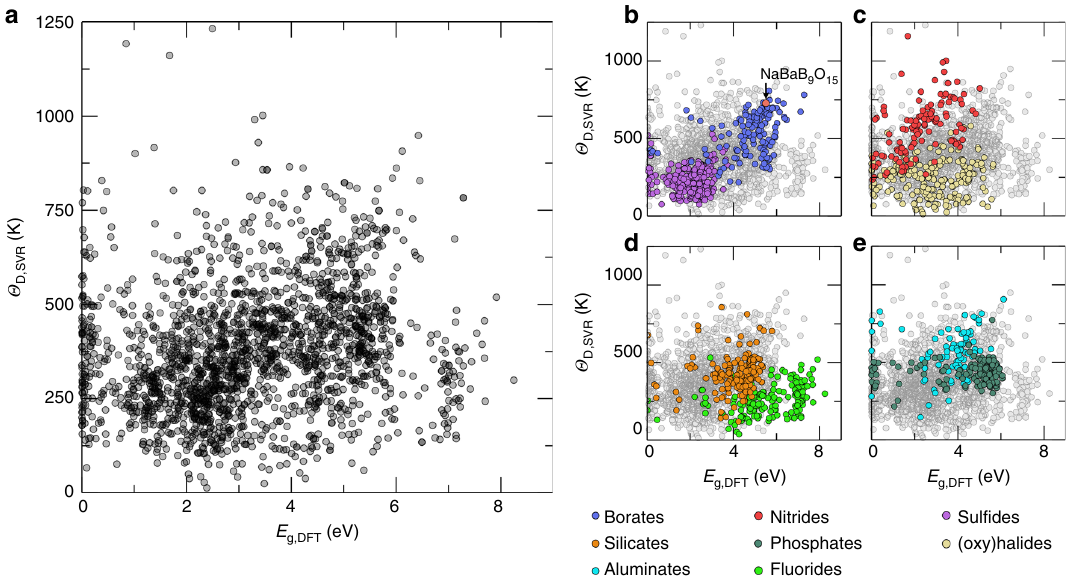
Fig. 3 Machine learning predicted Debye temperature against calculated bandgap. a Machine learning predicted Debye temperature ( Θ D,SVR ) against the density functional theory calculated bandgap ( E g,DFT ) for 2071 compounds predicted. The darker regions occur where there are overlapping data. Classes of common phosphor hosts are highlighted, including b borates and sul fi des, c nitrides and (oxy)halides, d silicates and fl uorides, and e aluminates